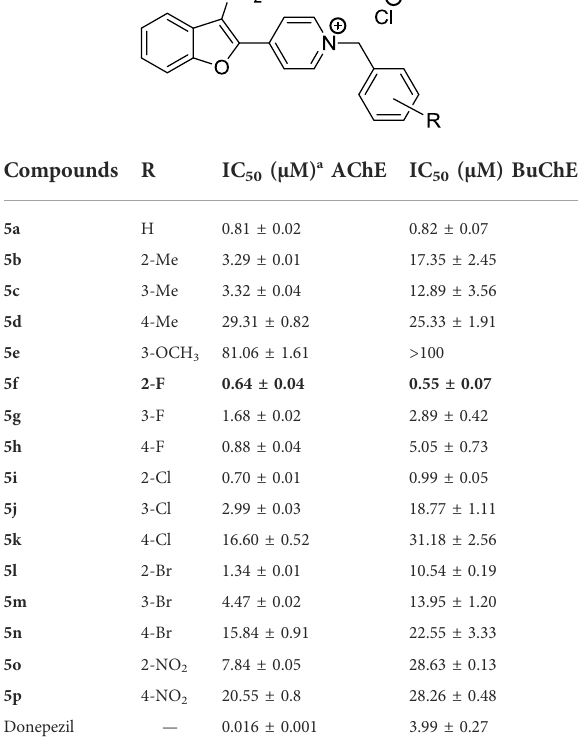
TABLE 1 Inhibitory activity of the target compounds 5a-p against AChE and BuChE.